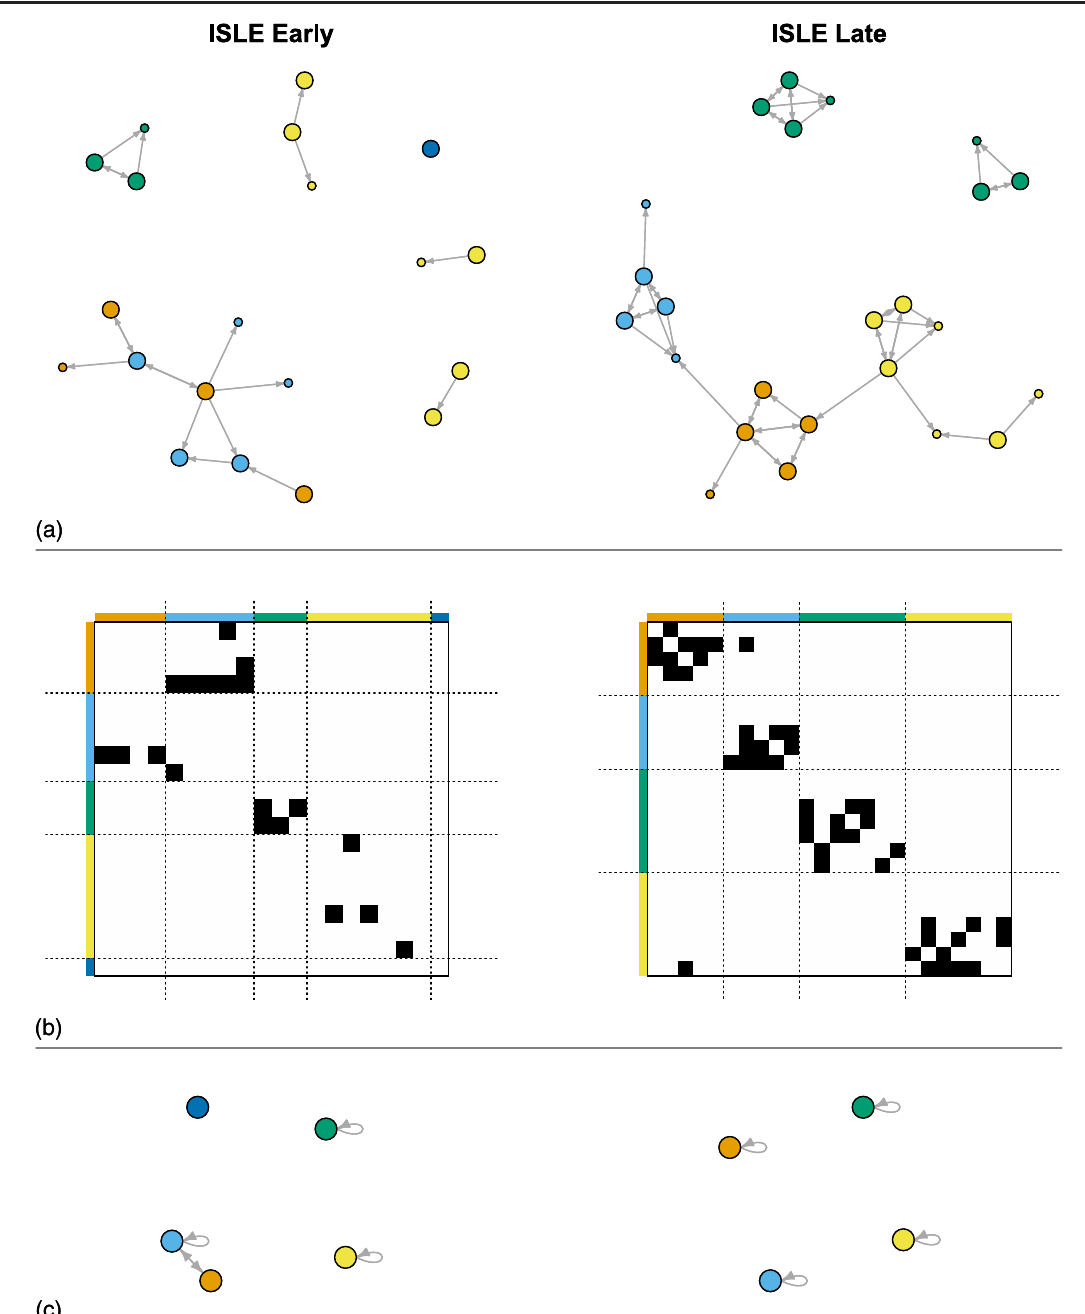
FIG. 5. (a) Network diagrams, (b) blockmodels, and (c) reduced network diagrams for ISLE section. Smaller circles on the network diagrams are students who did not take the survey but were named by respondents. Nodes are colored by CONCOR partition, and dotted lines on the blockmodel plots show the same